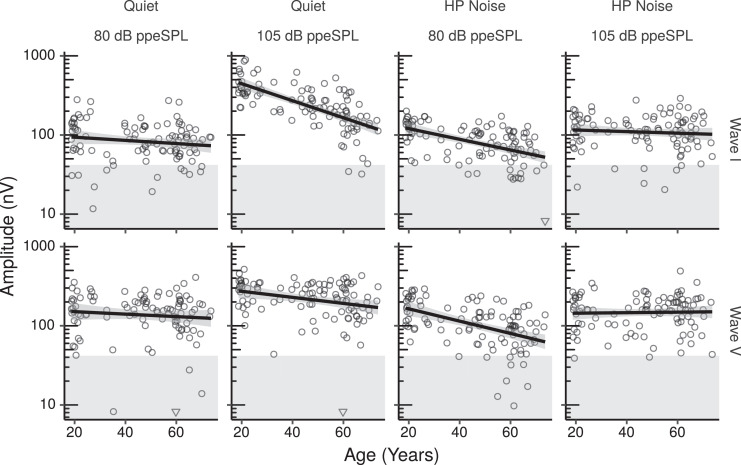
ABR wave I and V amplitudes by age for the HF-ITPR montage. The inverted triangles represent data points for which the peak-trough amplitude could not be measured. These data points were modeled as having an amplitude lower than the lowest recorded peak-trough amplitude in the dataset through a censored analysis. Each panel shows a least squares line fit of wave amplitude by age with 95% confidence intervals as a visual aid. The slope for the effect of age estimated by the Bayesian multiple regression model is not the same as that shown in the figure.